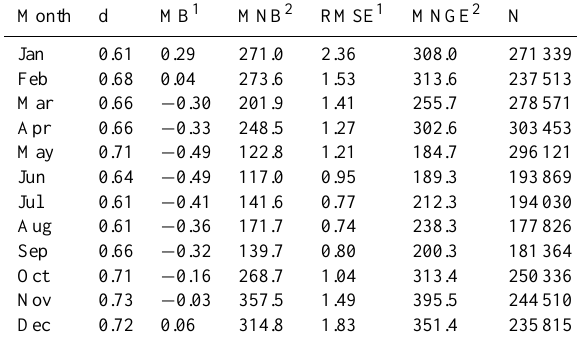
Table 4. Seasonal variation in index of agreement (d), mean bias (MB), mean normalized bias (MNB), root-mean-square er- ror (RMSE) and mean normalized gross error (MNGE) computed using the co-located WRF-Chem and OMI tropospheric column NO 2 values. The total number of data points (N) used in the cal- culation is also